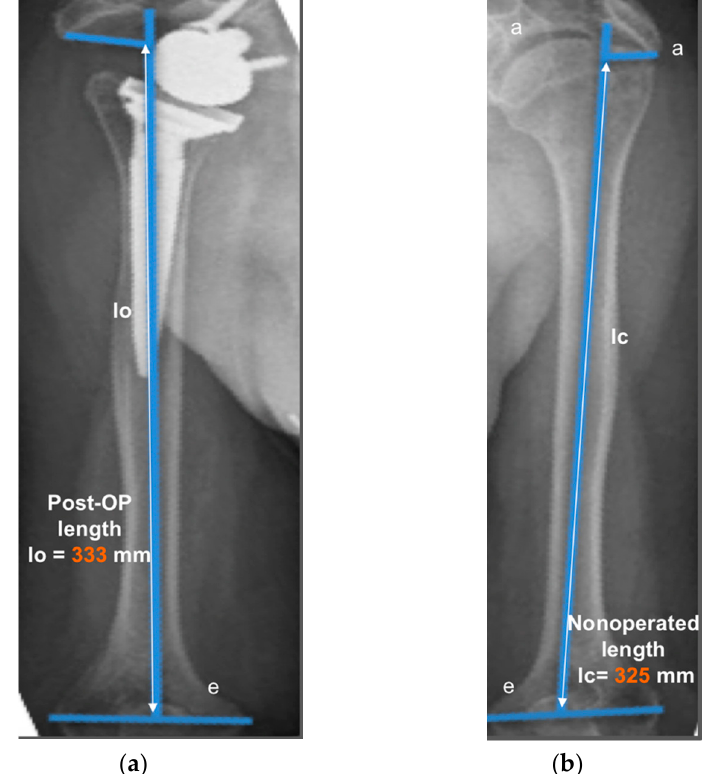
Figure 2. Measurement of humerus lengthening according to the protocol of Greiner et al. [5] and Lädermann et al. [10]. The humeral shaft axis was drawn, and the distance between the two lines “a” (subacromial line) and “e” (inter-epicondylar line) was measured as the humerus length for the operated (lo) ( a ) and non-operated side (lc) ( b ). The di ff erence between the operated and non-operated humerus length ( ∆ l = lo − lc) was considered as humerus lengthening if lo > lc. (8 mm for this representative patient).